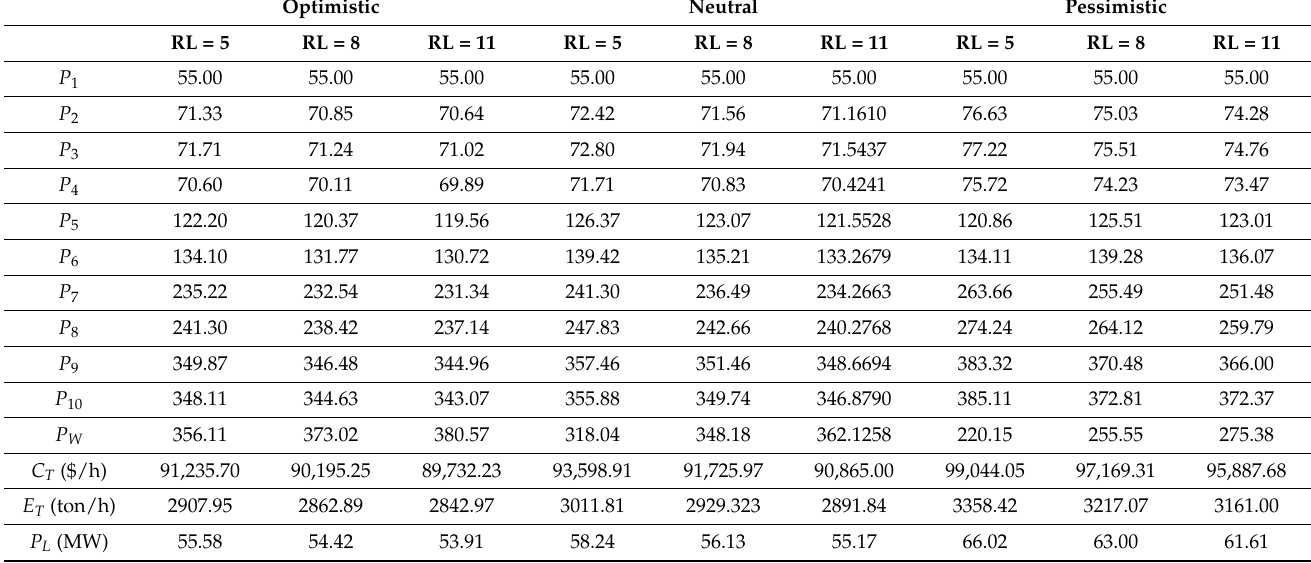
Table 4. Compromise solution in MW (Case